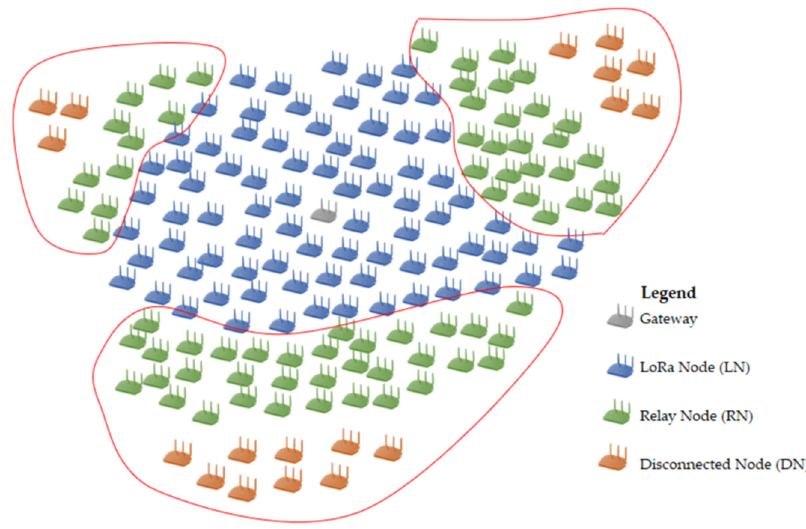
Figure 16. Simulation scenario with three blind spots.